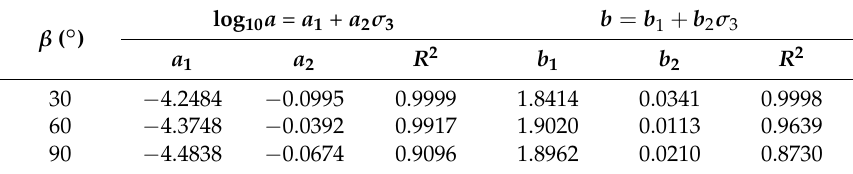
Table 4. Functions of a and b dependent on confining pressure σ 3 and the fitted constant parameters.